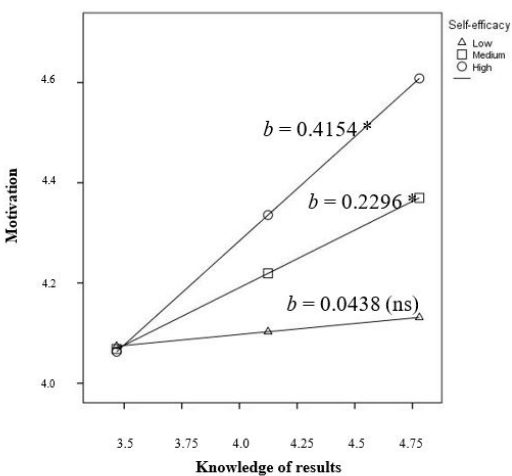
Figure 3. Moderator effect of self-efficacy on the relationship between knowledge of results and motivation on employees with physical disabilities (Note: ** p < 0.001, * p < 0.01)